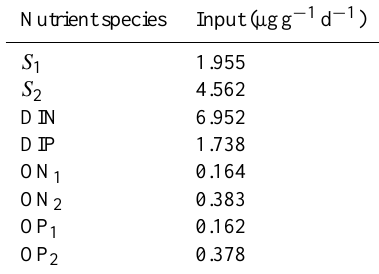
Table 6. Allochthonous deposition. Nutrient